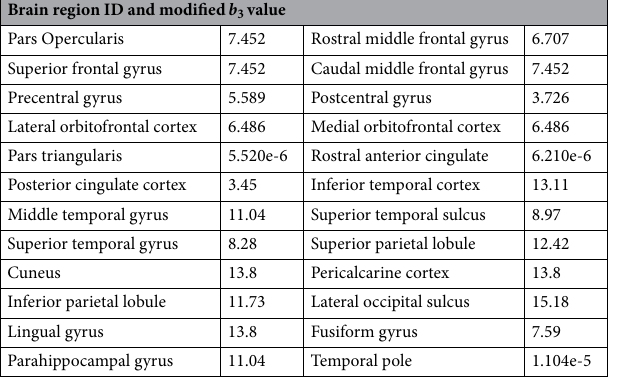
Table 3. Modified b 3 values.